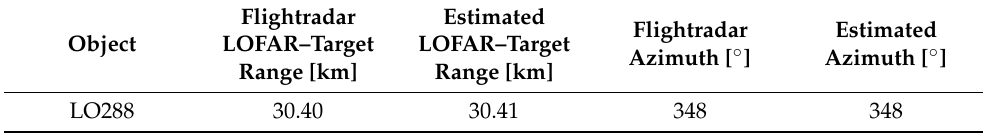
Table 6. Target range and azimuth—December